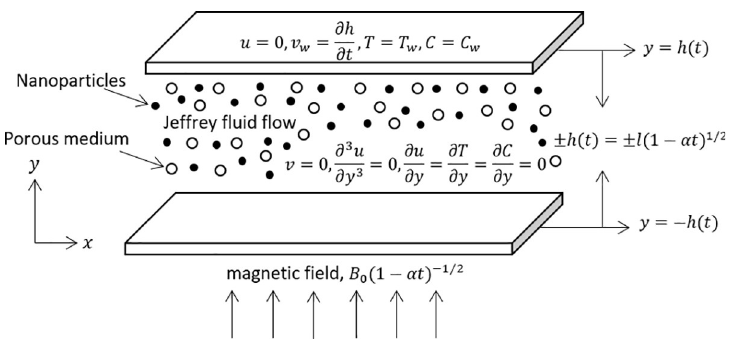
Fig 1. Coordinate system and geometrical